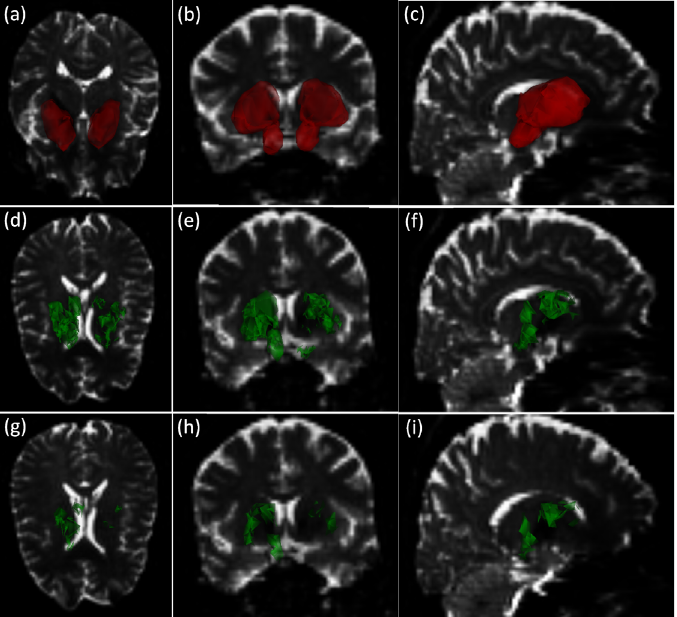
Fig 2. (a) — (c) are the axial, coronal, and sagittal views of the original ROI. (d) — (f), and (g) — (i) show the most discriminative voxels, with p-values < 0.05, and < 0.01,